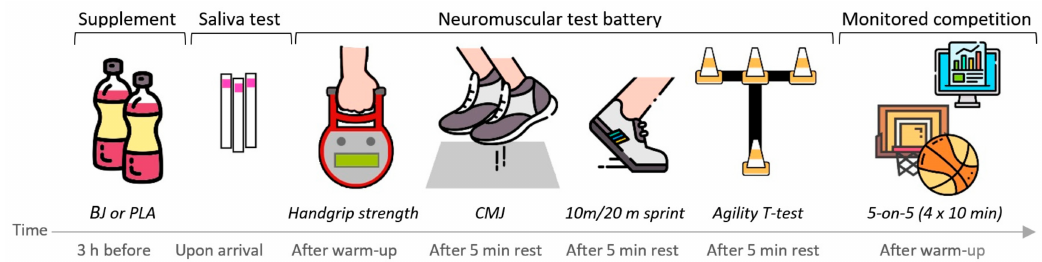
Figure 1. Experimental design of the